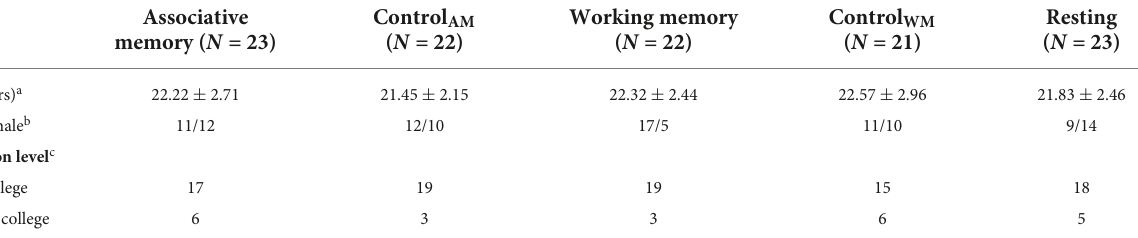
TABLE 1 Demographic data for experiment